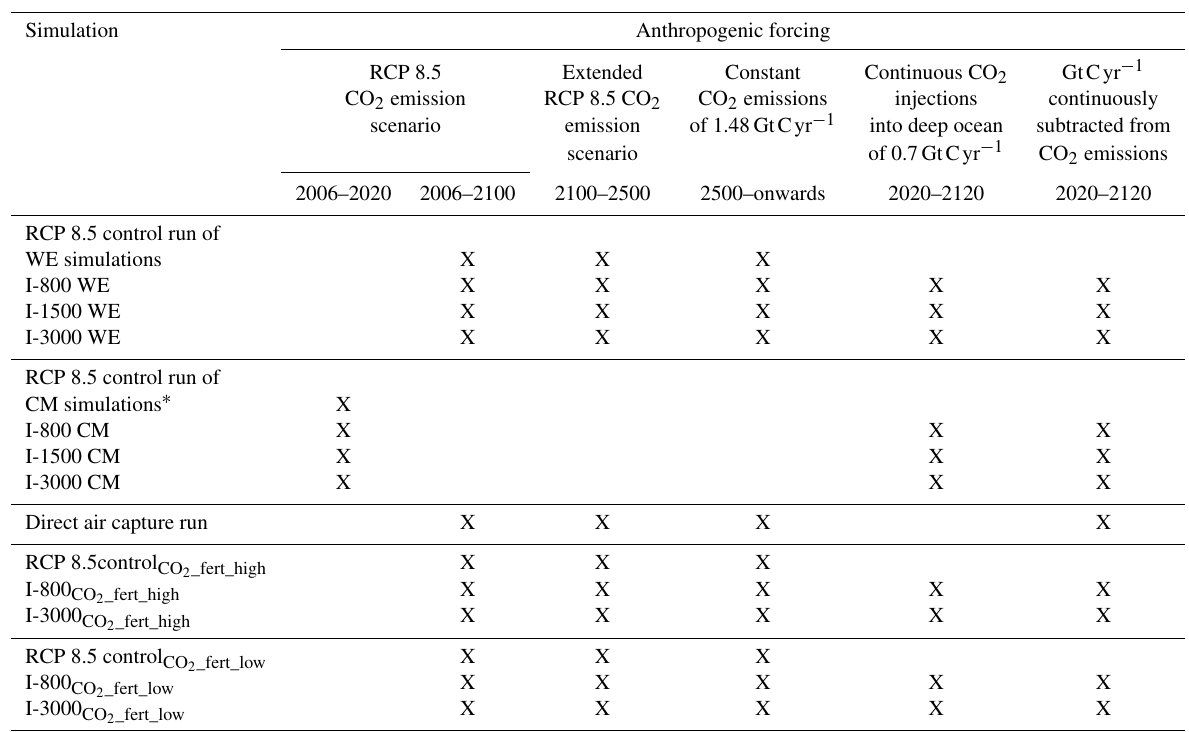
Table 1. Overview of all conducted simulations and their anthropogenic forcing. “X” denotes that the respective forcing is applied. WE: With Emissions; CM: Complete